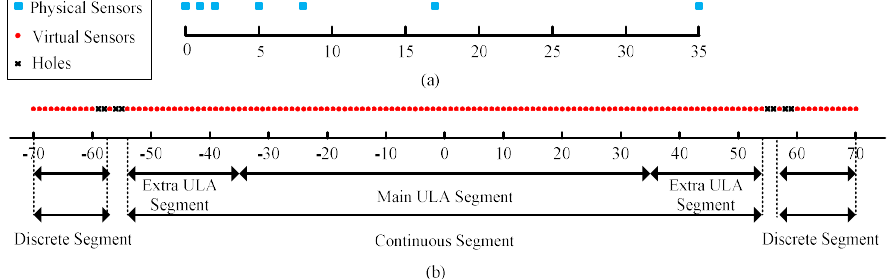
Figure 1. Example of the four-level nested array with N = 7 physical sensors. ( a ) Sensors positions of the physical array ( N = 7). ( b ) Corresponding fourth-order difference co-array.